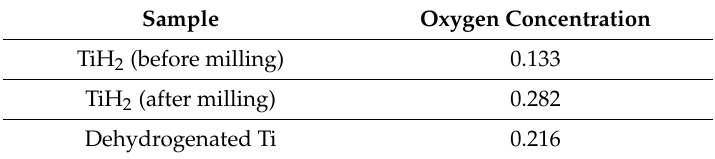
Table1. Oxygen concentration of TiH 2 beforeand aftermilling anddehydrogenationTi powders (wt Table 1. Oxygen concentration of TiH 2 before and after milling and dehydrogenation Ti powders (wt %).